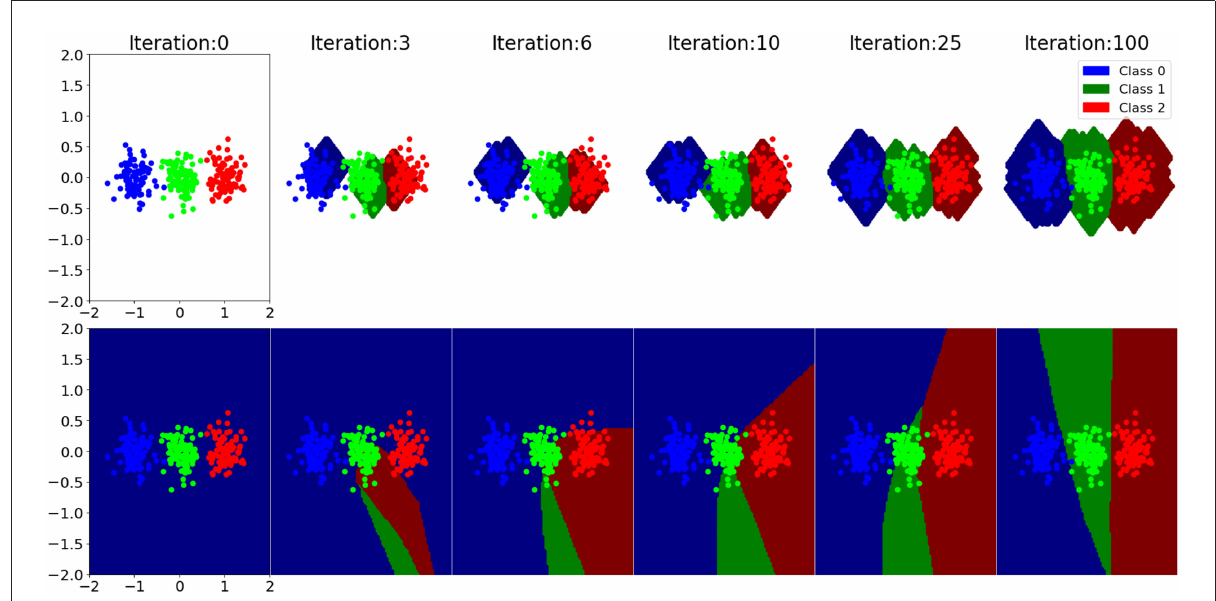
FIGURE3 A selection of training steps of EDN (top) and an ANN trained with gradient descent (bottom) are shown for a toy classification example. Each training iteration is a single input presentation with the boundary being displayed after the network has been updated to incorporate the training error. The data set is composed of three classes: blue, green, and red. Class boundaries are drawn in a darker shade than the data points showing what output each model would associate to that point in space. The white area around the EDN plots indicates that there are no output activation at that point in the input space, meaning all outputs are zero and, therefore, no class is